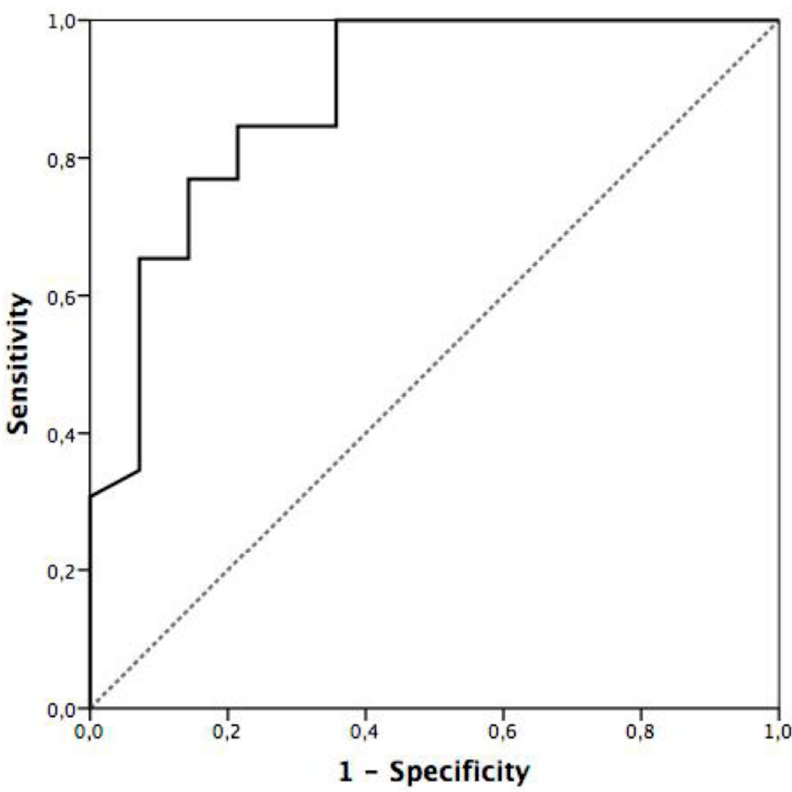
Figure 1. Receiver operating characteristic (ROC) curve to assess the ability of platelet count at admission to identify patients with progressive and non-progressive disease. Area under the curve (AUC) was 0.889 (0.78–1.0), p < 0.001.